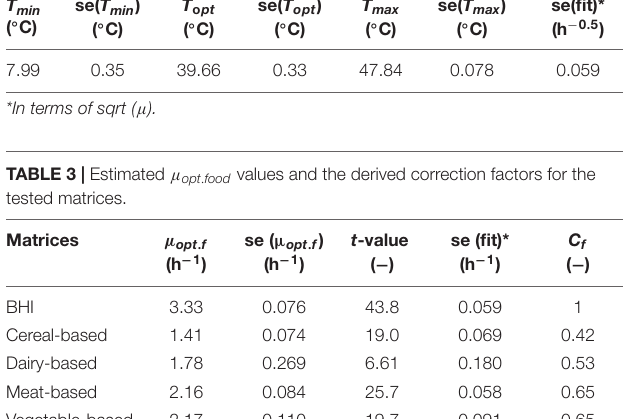
Frontiers in Microbiology |